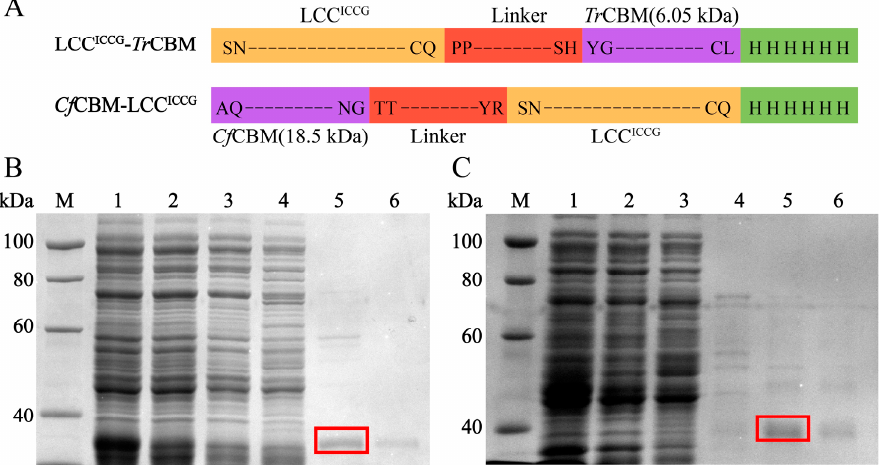
Figure 2. Schematic illustration of the constructed fusion enzymes based on LCC ICCG with CBMs ( A ). SDS-PAGE analysis of LCC ICCG - Tr CBM ( B ) and Cf CBM-LCC ICCG ( C ) expressed in E. coli BL21(DE3) during the purification using Ni 2+ -Sepharose 6FF column. Lane M: marker; lane 1: lysates of whole bacterial cells; lane 2: supernatants of lysates; lane 3: effluent fractions of loading sample; lane 4: the fraction eluted with 50 mM imidazole; lane 5: the fraction eluted with 200 mM imidazole; lane 6: the fraction eluted with 500 mM imidazole.